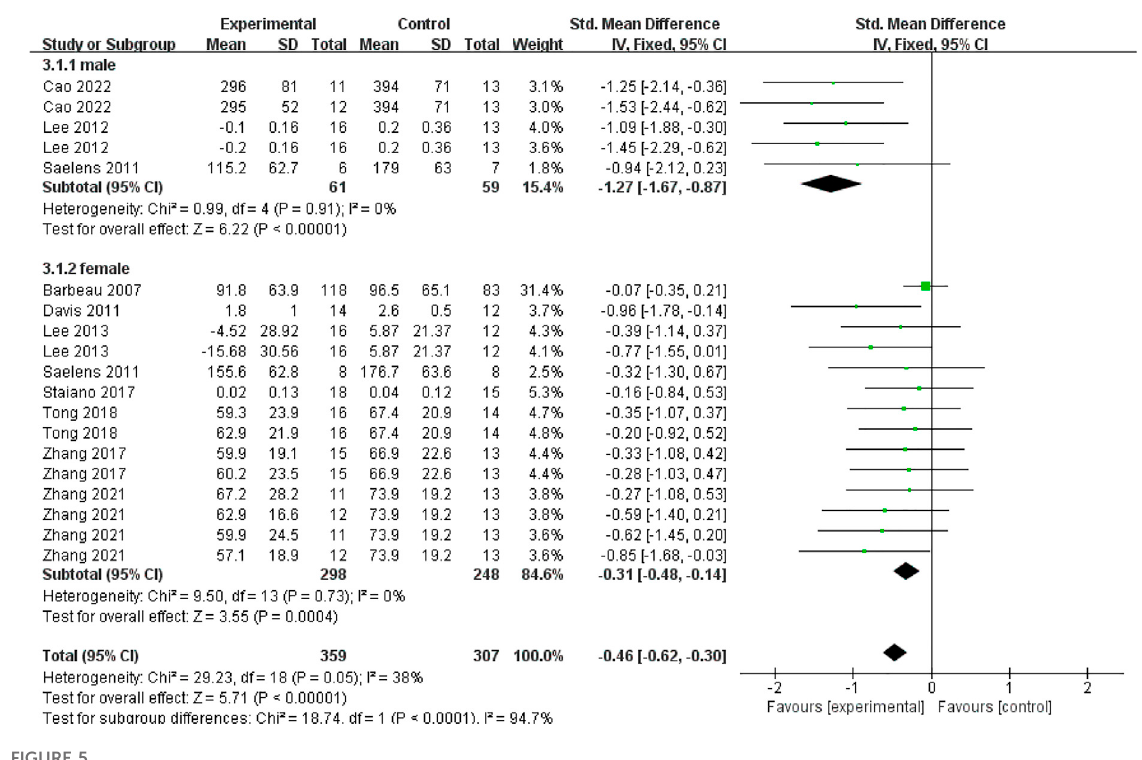
FIGURE 5 Subgroup analysis of gender related to the effect of exercise interventions on visceral fat in young individuals with obesity or